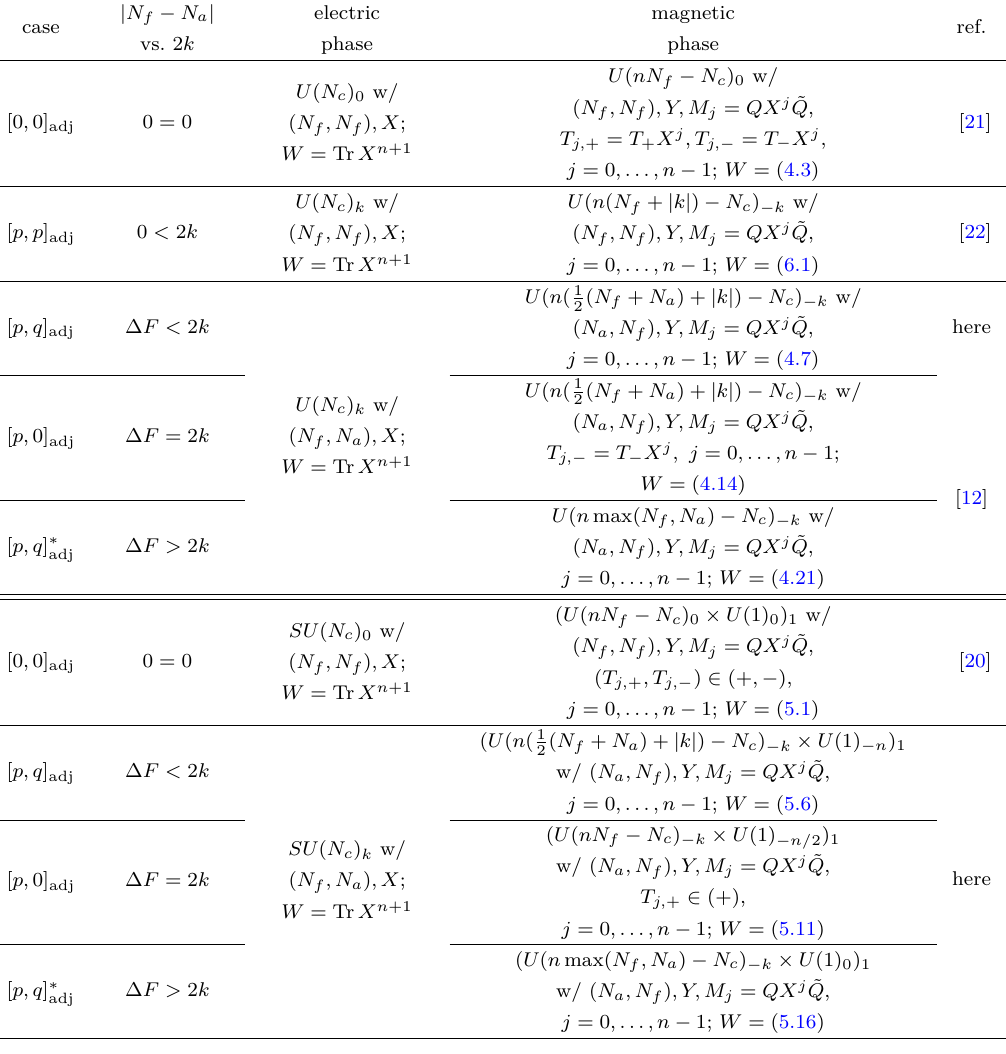
Table 2 . Summary of chiral dualities for U ( N c ) and SU ( N c ) adjoint SQCD with ( N f , N a ) ∈ ( N c , N c ) matter fields, and one field X in the Adj of the electric gauge group. The dual adjoint field in the magnetic phase is Y . The notation is as in table